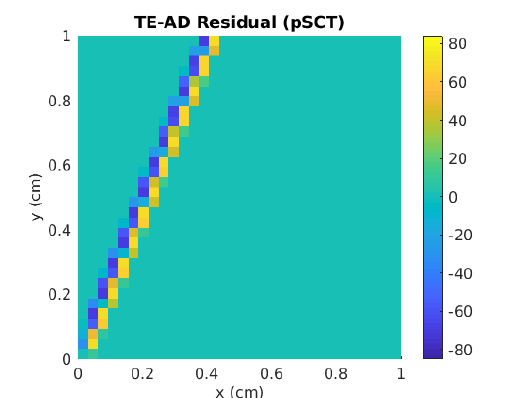
Figure 5: Cell-Wise TE-AD Residual (with pSCT) for a Single